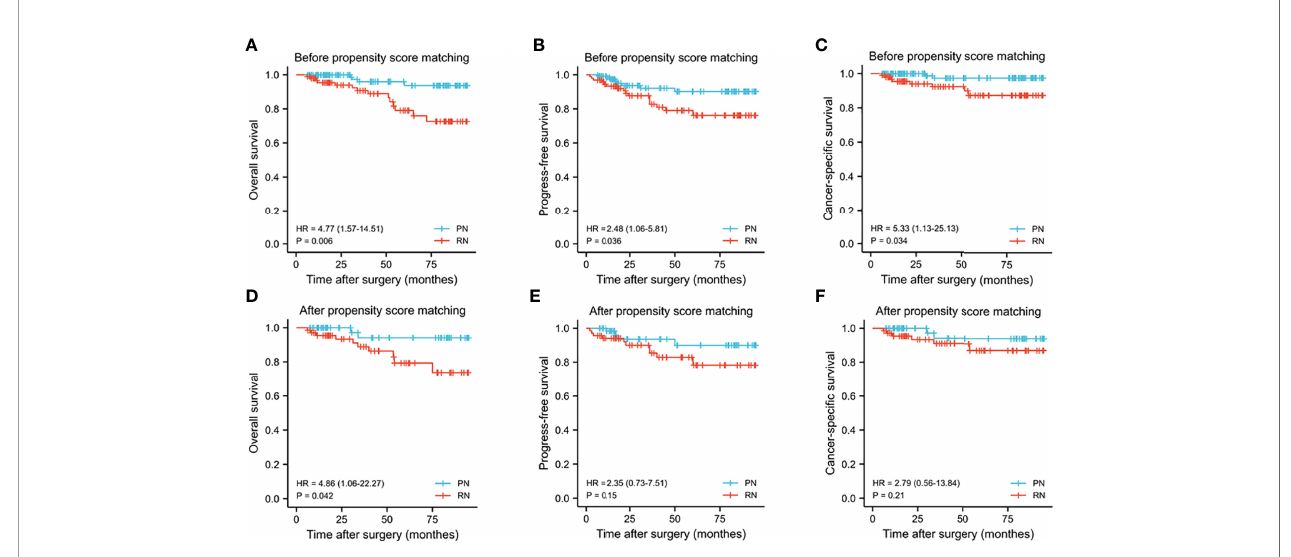
FIGURE 3 | Kaplan – Meier curves for overall survival (A, D) , progress-free survival (B, E) , cancer-speci fi c survival (C, F) between the PN and RN groups before and after propensity score matching. PN, partial nephrectomy; RN, radical